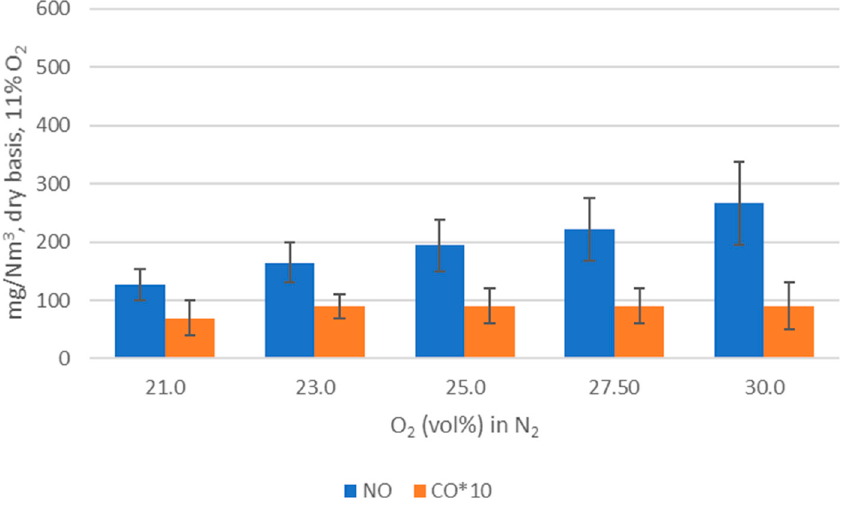
2 /CO 2 oxidizer mix.